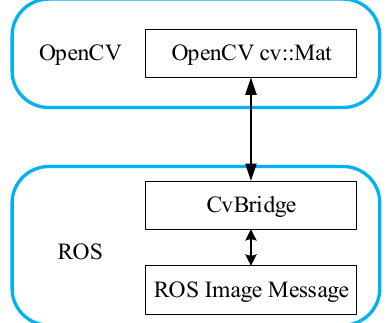
Figure 4. Calling OpenCV in robot operating system (ROS).